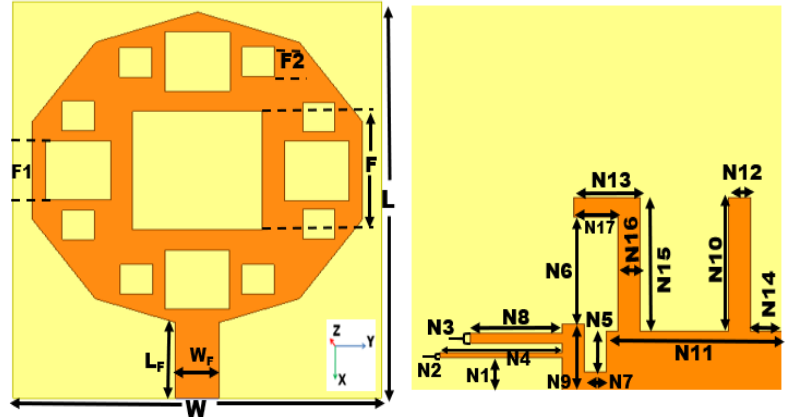
Figure 13. UWB notch antenna S11 features .